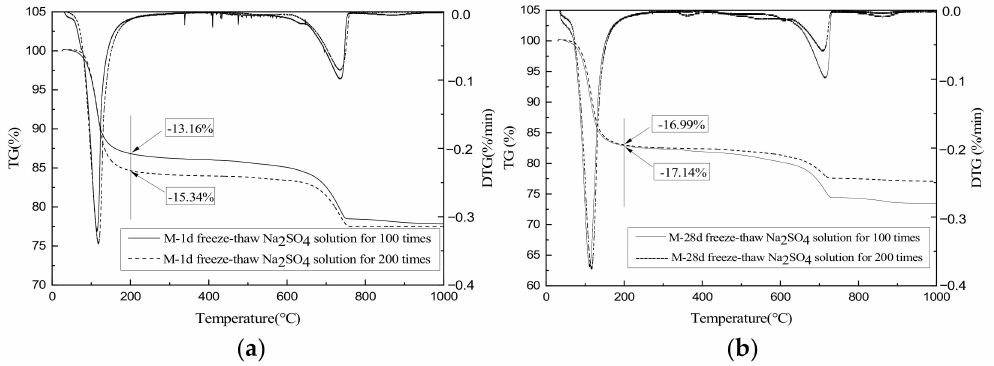
Figure 9. TG-DTG diagrams of MKPC mortar specimens. ( a ) M-1d. ( b )